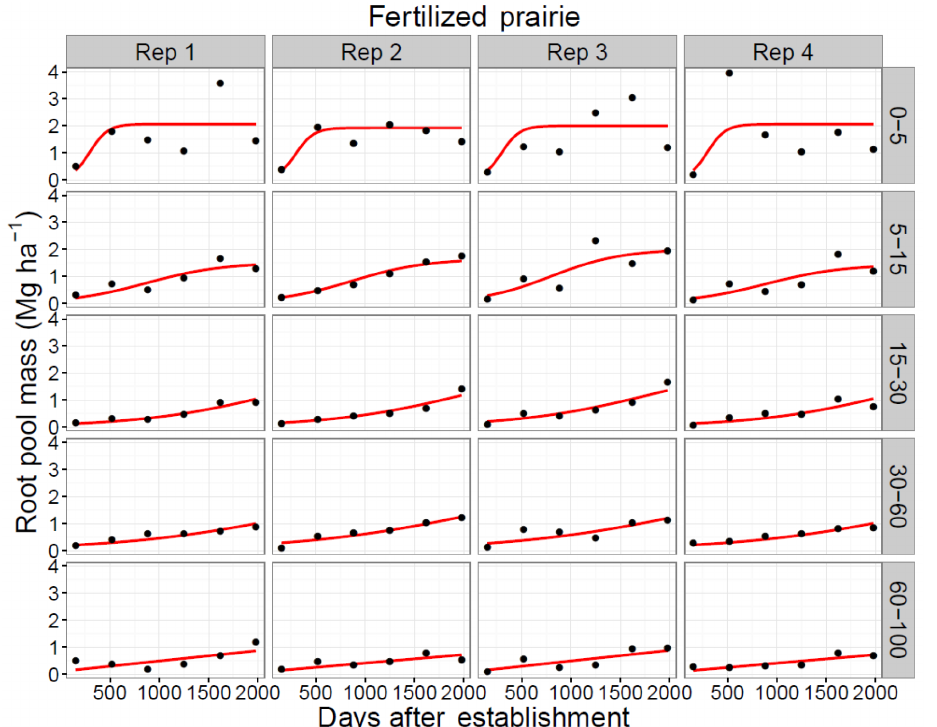
Figure A2. Logistic curves fit to root pool mass accumulation at each replication and depth increment in the fertilized prairie treatment.